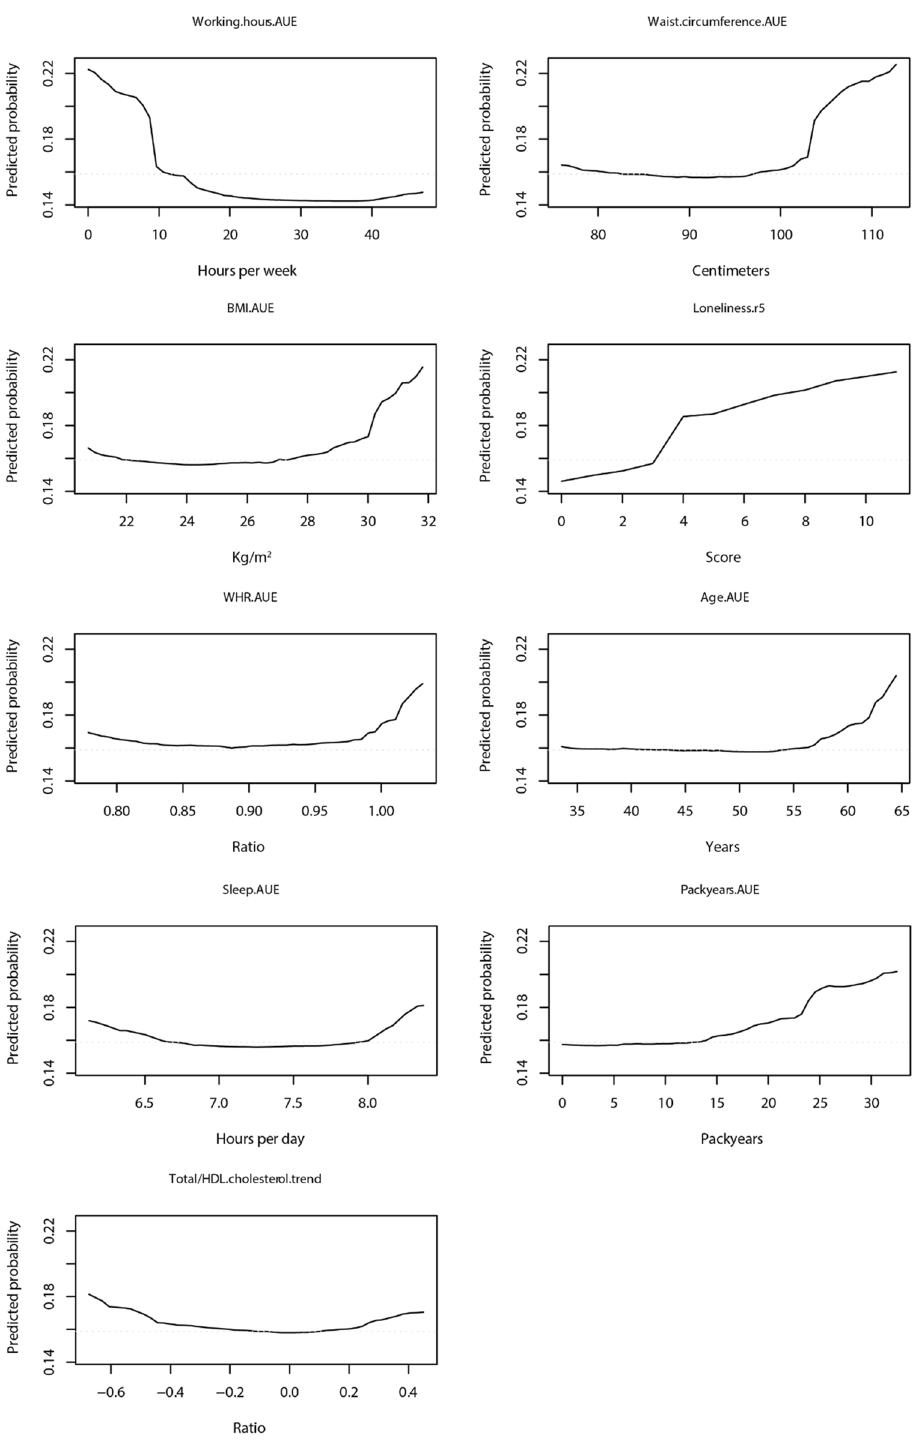
Figure 6. Partial dependence plots (PDPs) of the relation between predictors of self-perceived health and poor self-perceived health. The dotted gray line represents the reference value, i.e. the predicted outcome corresponds to the prevalence of poor perceived health in the total population at round 6 (0.16). AUE, Area-Under-the- Exposure; BMI, body mass index; r5, round 5; WHR, waist/hip